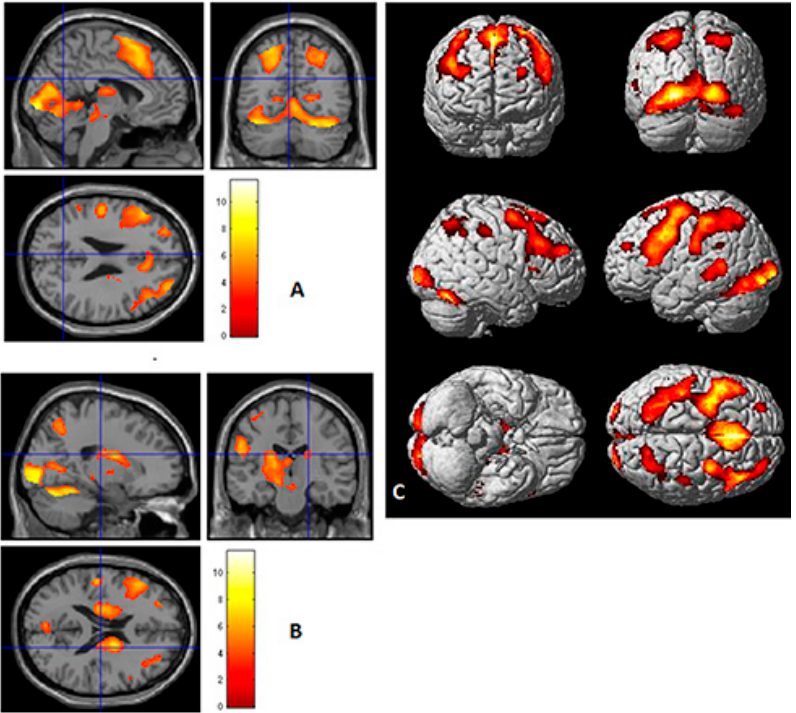
Figure 3. Localizer scan, region of interest analysis (ROIs). One sample t -test for “Sentences versus Baseline” overall activation. Note for n = 40, t = 3.312788 ( p < 0.001). Twenty-two ROIs were identified by this approach (see Table 2). ( A ) One sample t -test Sentences vs. Baseline overall activation sectioned at the precuneus (sagittal, coronal, and transverse). ( B ) One sample t -test Sentences vs. Baseline overall activation sectioned (sagittal, coronal, transverse) at the level of the thalamus. ( C ) One sample t -test Sentences versus Baseline overall activation. Table 2. Summary of regions of interest (ROI): 22 ROIs were identified from data associated with Figure 3. Note ( p < 0.05) (Talairach coordinates Brodmann area (BA), hemisphere (H)).